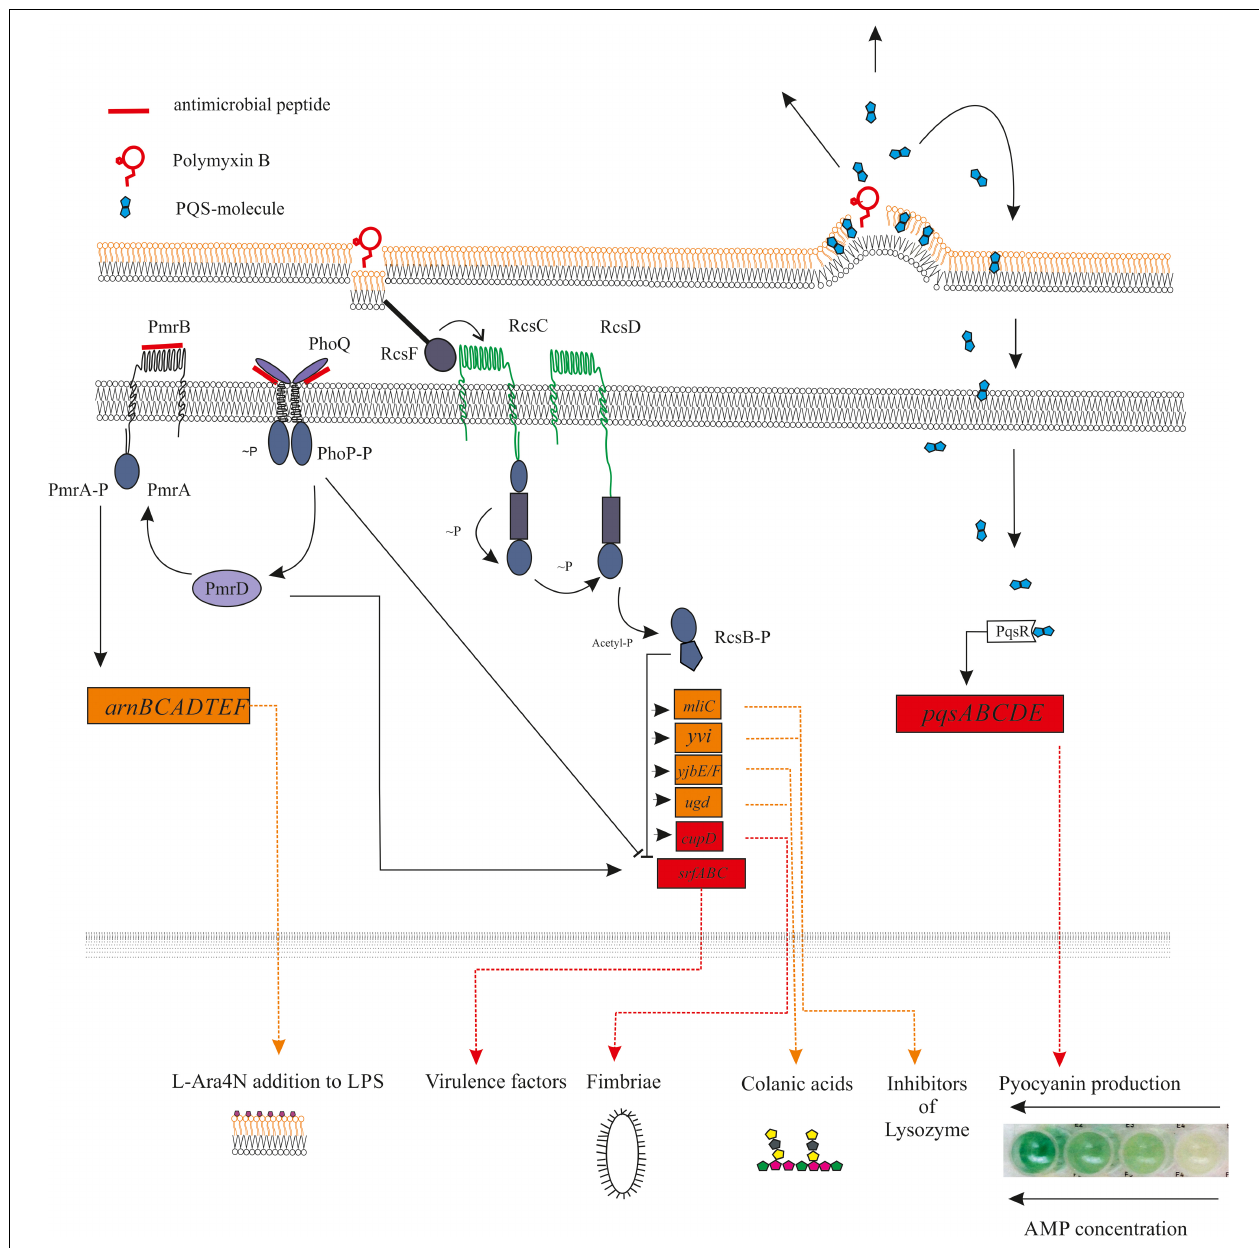
FIGURE 1 | Diagram showing the main receptors of antimicrobial peptides and the relationship between them. The mechanisms of signal transmission from the activated receptor to the corresponding genes are shown. Antimicrobial peptides is capable to direct (PhoQ, PmrAB, and other) or indirect (RcsF) activation of the histidine kinase sensors, which led to regulation of activity of appropriated genes. At the same time, the expression of some genes can simultaneously be under the positive and/or negative regulation of different TCS. For example, the effect of polymyxin B on the bacterial outer membrane can activates the RcsF sensors, what leads to inhibition of expression of virulence genes in srfABC operon. Interestingly, the same operon is activated by another TSC PmrAB, for which “Peptide Sensing” was revealed (for example, for